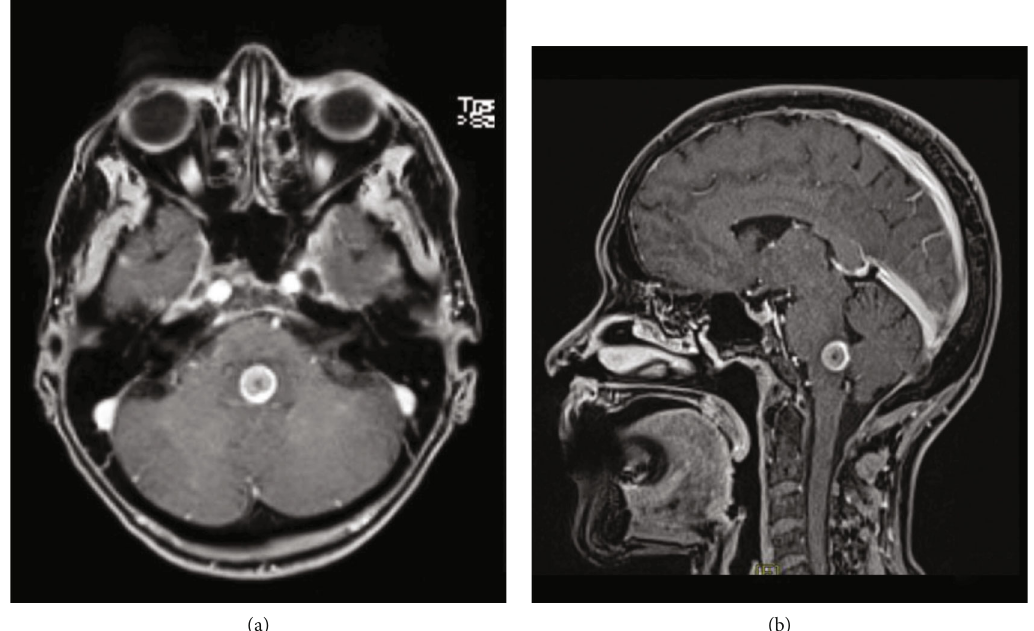
Figure 1: (a) Preoperative contrast-enhanced MRI shows a 13mm intrinsic, roundish lesion in the posterior pontomedullary junction. (b) The fl oor of the inferior IV ventricle is slightly raised, and the tumor slightly protrudes from it.